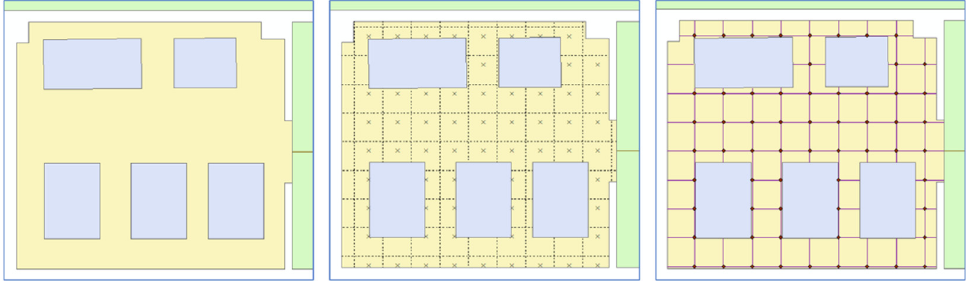
Figure 19. Generating a Level 4 network for the same room using tessellation.